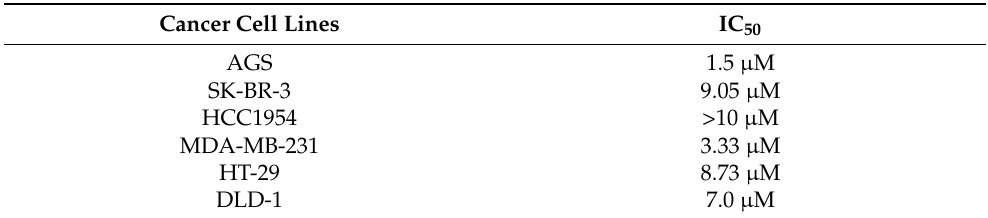
Table 1. Viability of AGS, SK-BR-3, HCC1954, MDA-MB-231, HT-29, and DLD-1 cancer cells after 24 h of Les-4367 exposure estimated by MTT assay.